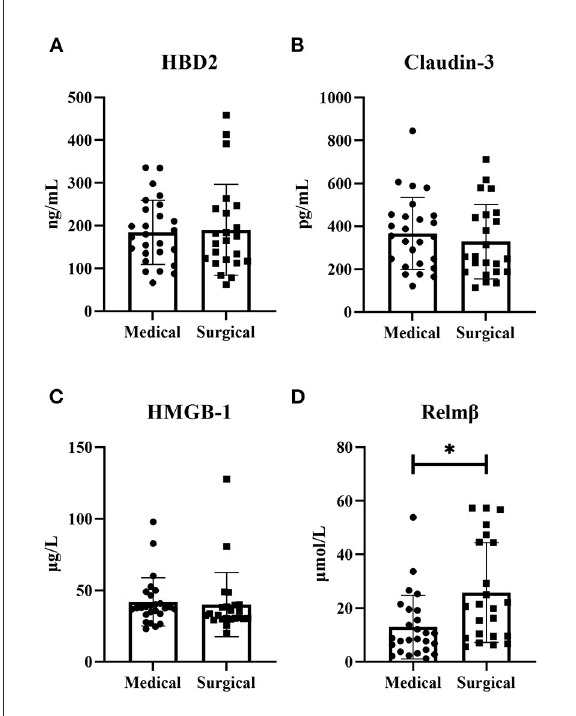
FIGURE2 Concentrations of serum biomarkers in the two groups. The concentrations of HBD2, Claudin-3 and HMGB-1 showed no difference between the two groups ( P > 0.05) (A—C) . The concentration of Relm β in the surgical group was significantly increased compared with that in the medical group ( P < 0.05) (D) .